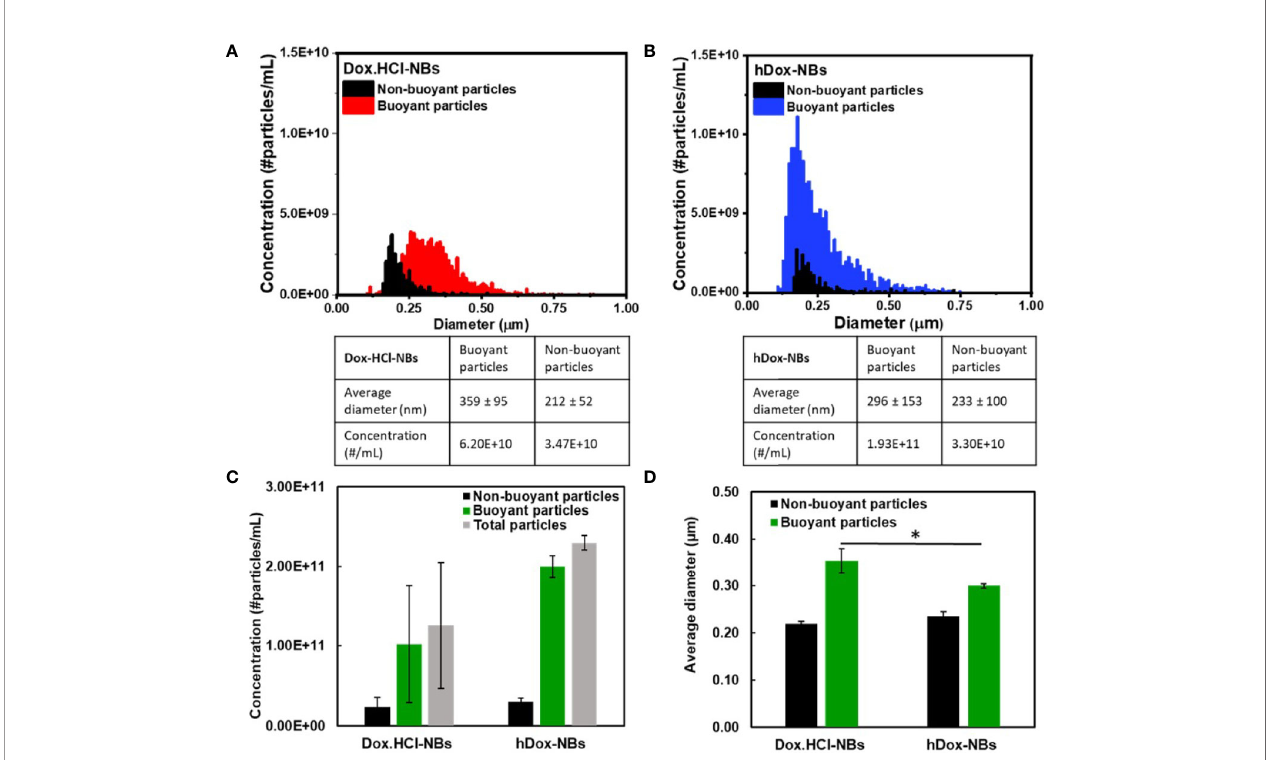
FIGURE 1 | Representative histograms showing the size distribution and concentration of (A) Dox.HCl-NBs (n=3) and (B) hDox-NBs (n=3), as measured by resonant mass measurement (RMM); The data is summarized to facilitate comparison between groups for both the (C) concentration and (D) size of buoyant and non-buoyant particles for the two different bubble formulations. Both bubble types were found to have similar concentrations of both buoyant (bubbles) and non- buoyant (solid lipids/aggregates), although the results from Dox.HCl-NBs were more variable and the concentration was on average 50% lower. The results were not statistically signi fi cant. The average bubble size of hDox was 25% smaller than Dox.HCl. Asterisk indicates signi fi cant difference at p <